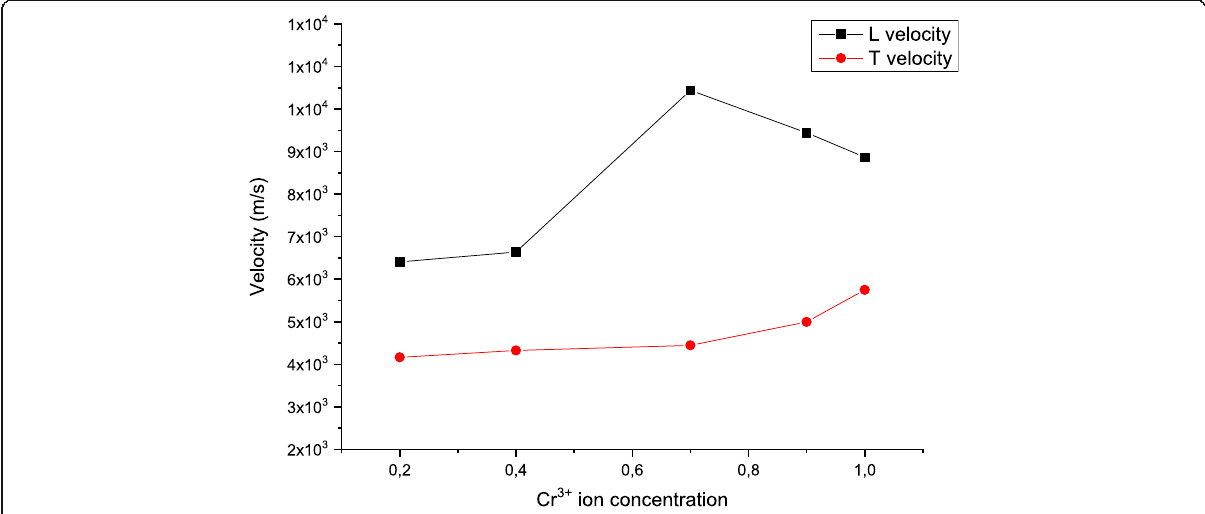
Fig. 1 Variation of the shear and longitudinal sound velocity with Cr 3+ ion concentration in the spinel structure of Mn-Cr